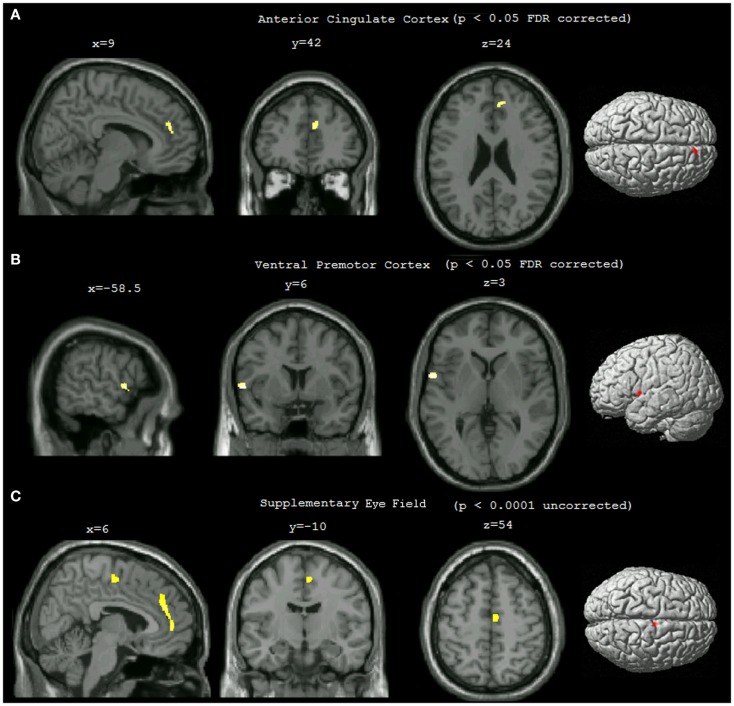
Statistical parametric maps showing differences in gray matter density between pilots and non-pilots. The maps were overlaid on the MNI aligned 3D image of a selected single subject and rendered on the average brain surface provided in SPM8. (A) Right anterior cingulate cluster (p < 0.05 FDR corrected, cluster threshold = 25). (B) Left ventral premotor cortex cluster (p < 0.05 FDR corrected, cluster threshold = 25). (C) Right supplementary eye field (p < 0.0001 uncorrected, cluster threshold = 25).